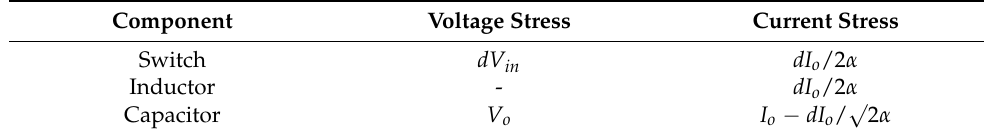
Figure 6. Gain variation with the duty cycle for fixed DC link voltage and on different loads. Based on circuit equations, voltage and current stress across each component can be tabulated as shown in Table 1. Table 1. Voltage and current stress.